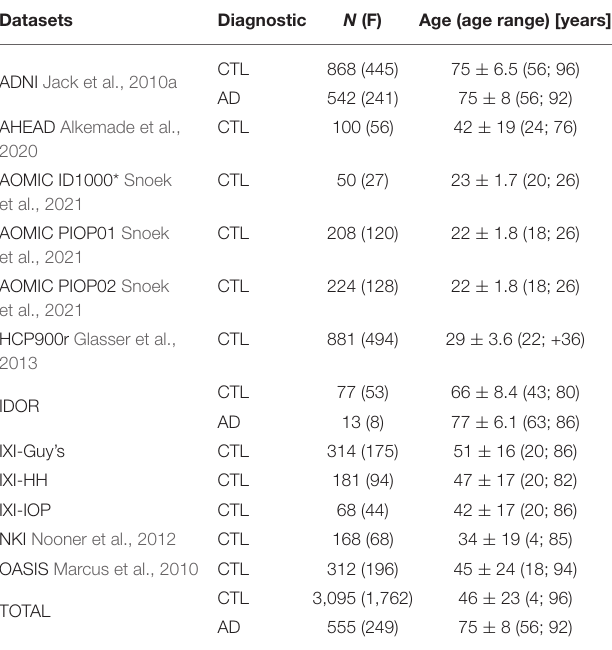
TABLE 1 | Summary for each